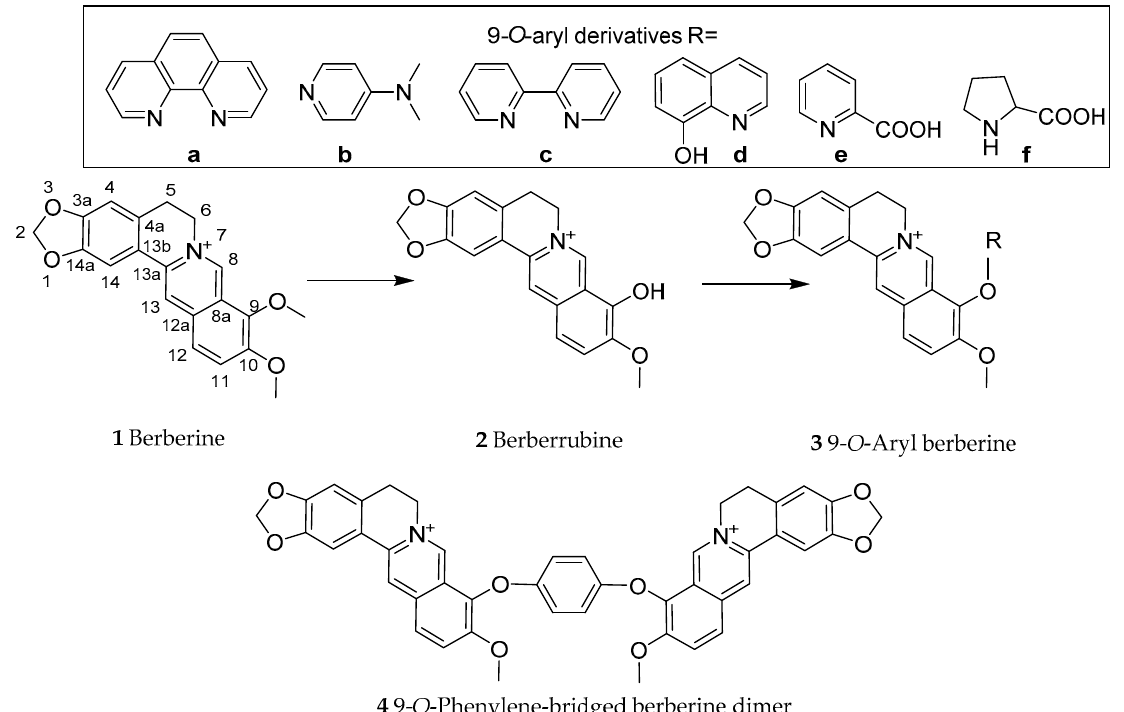
Figure 1. Berberine dimer formation via copper-catalysed aryl- O -coupling synthesis approach [34].